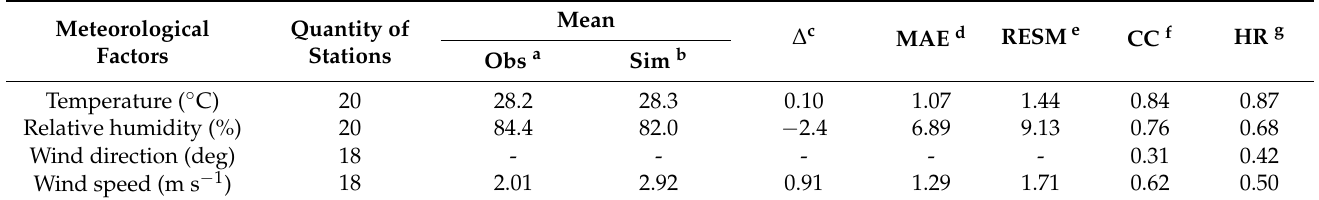
Table 3. The statistical results of simulated data and hourly observed meteorological